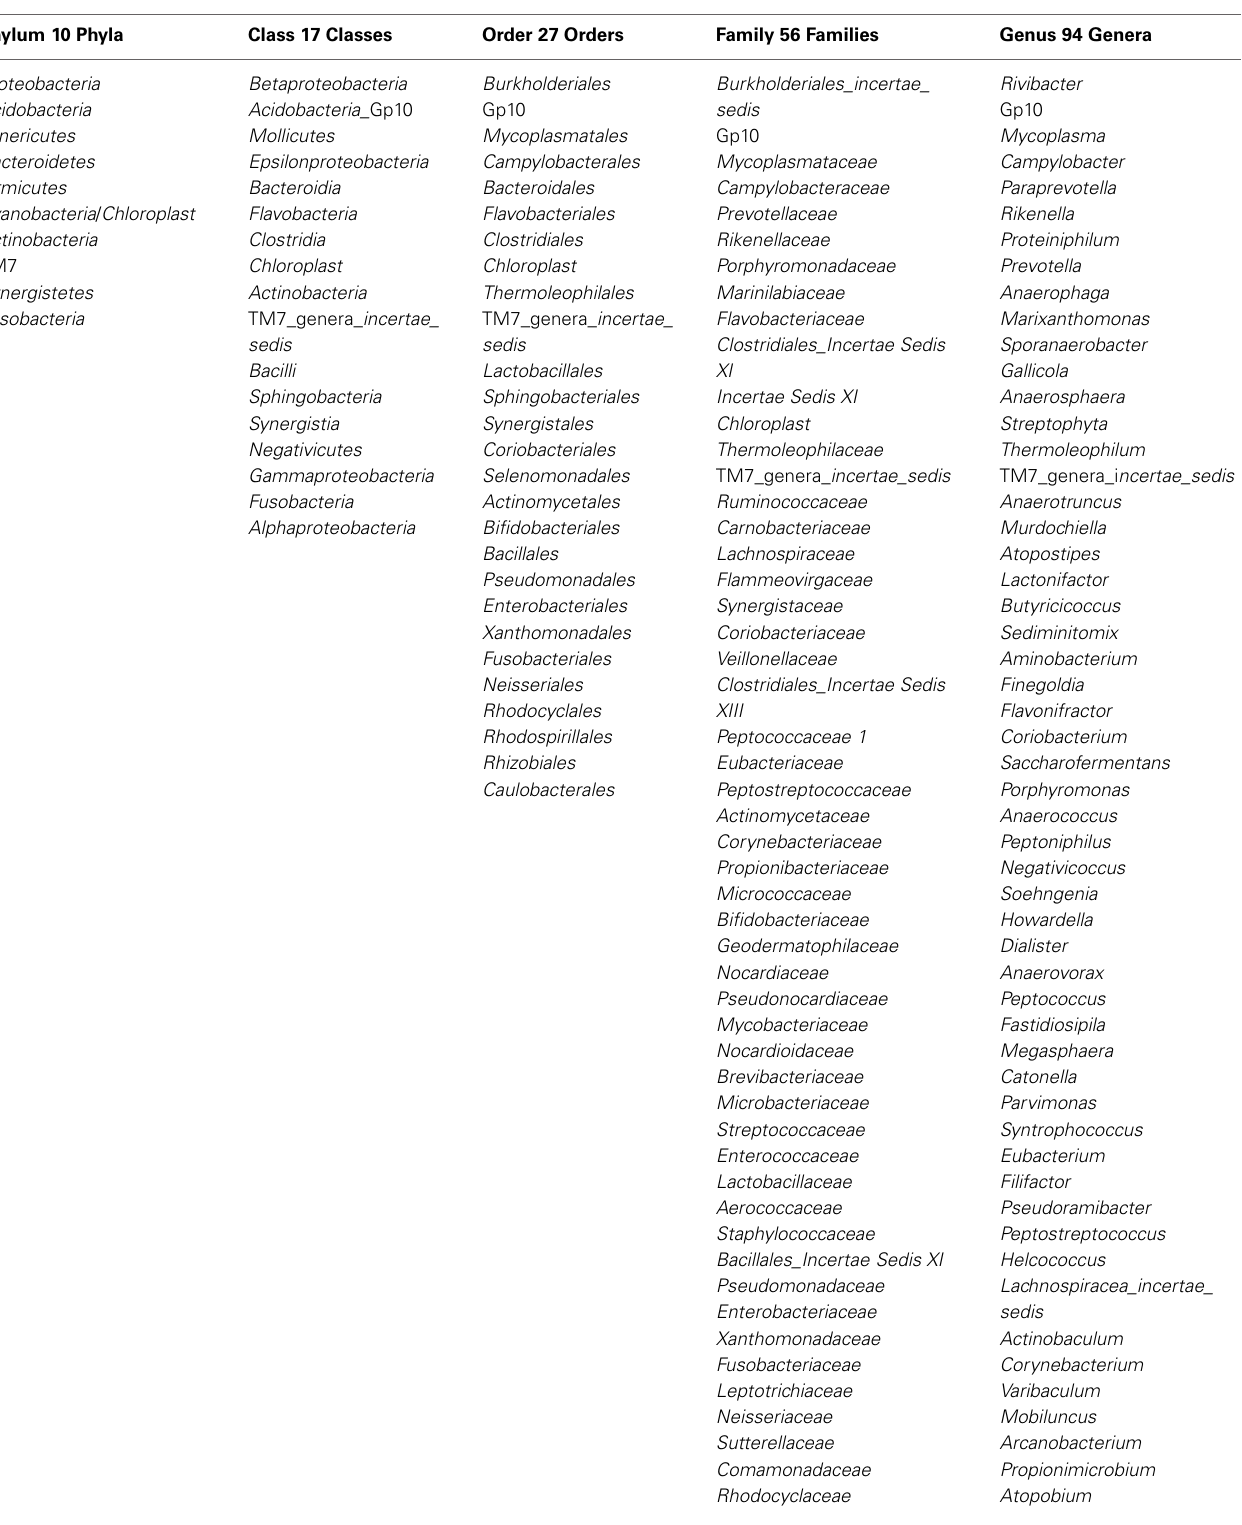
Table A1 | The taxonomic groups identified for all the samples at the Phylum, Class, Order, Family, and Genus